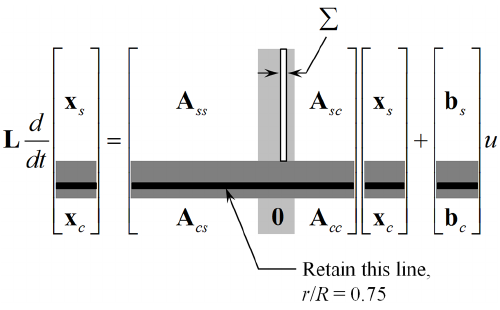
Figure 7. A sketch of the matrix operations used to reduce the num- ber of aerodynamic states. The input u is the weighted rotor-average rotationally sampled wind speed, by way of Eq.